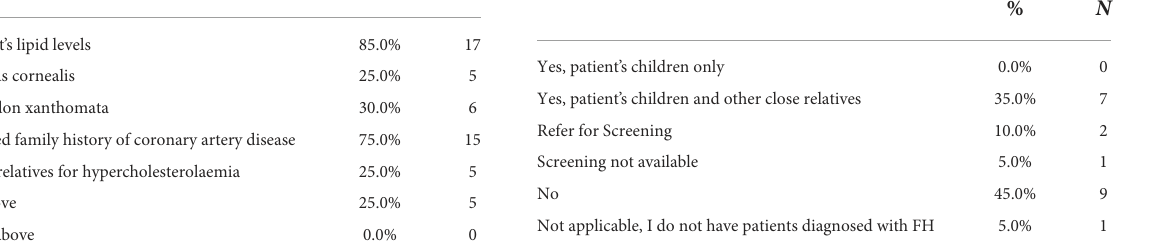
TABLE 4 If you have patients with familial hypercholesterolaemia under your care, do you routinely screen close relatives for this condition with a lipid %